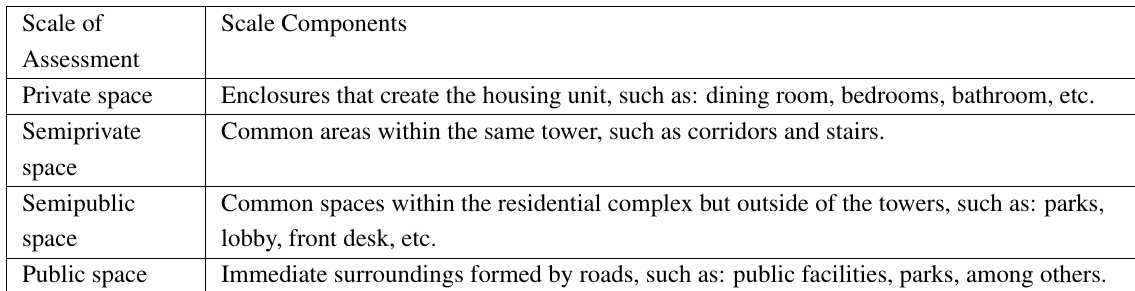
Table 3. Scale of Assessment